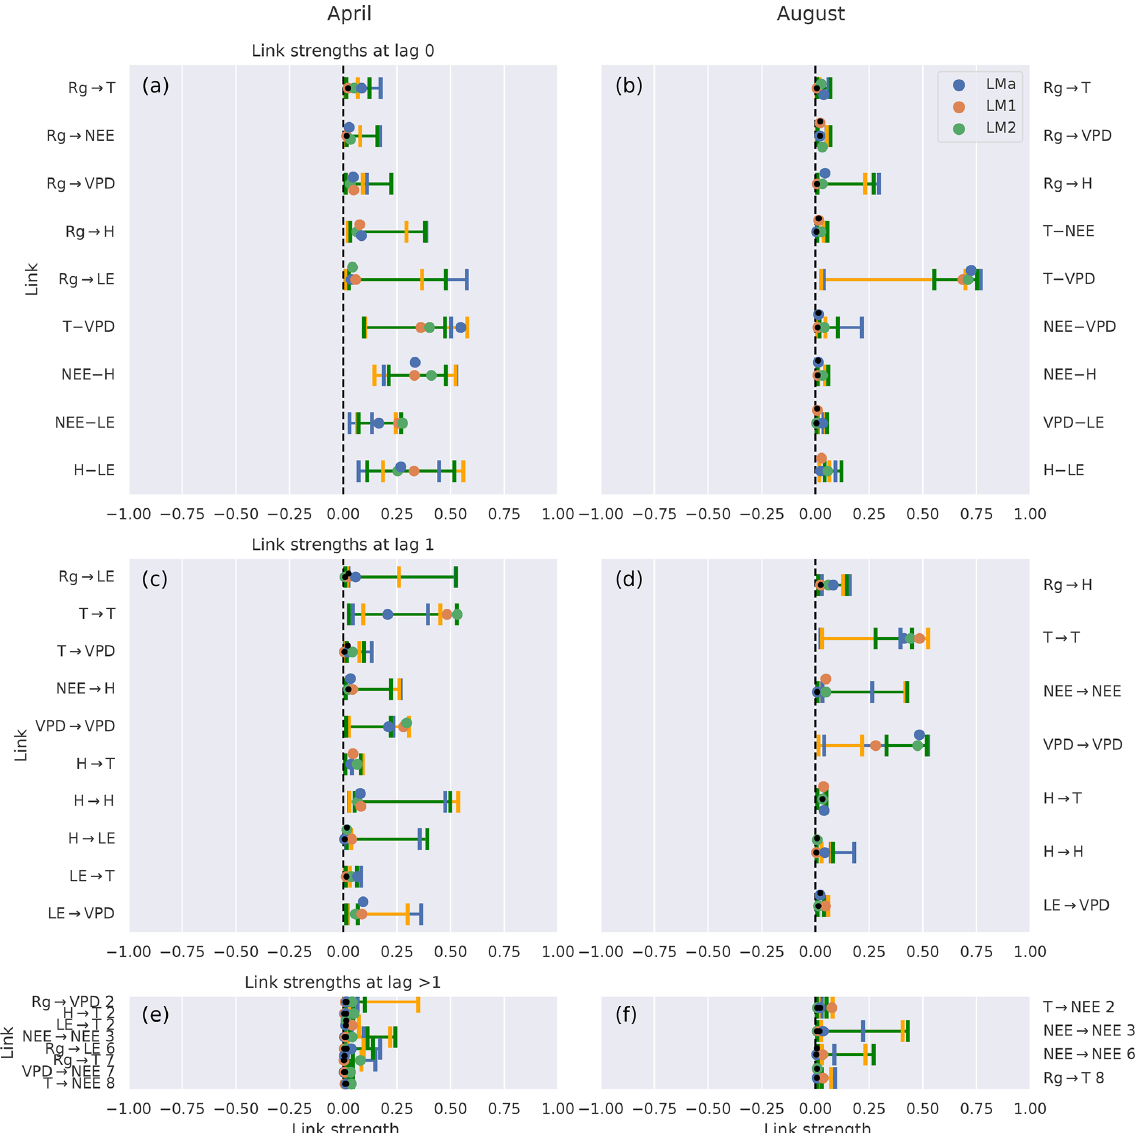
Figure A7. The same as Fig. 4, but the analysis was performed using a non-linear independence test. Comparison of the networks of three eddy covariance measurement stations (LMa, LM1, LM2) located in Majadas de Tiètar (Spain). Links that are found to be significant in one of the three networks are included. For each link, the calculated strength of all three networks is plotted with its 90% confidence interval. The colours blue, orange, and green correspond to the towers LMa, LM1, and LM2, respectively. The significance threshold is 0.01. If a link does not pass the significance, it is marked by a black dot. The links are grouped into lag 0 (a, b) , lag 1 (c, d) and all lags greater than 1 (e, f) . Links at lag 0 are left undirected ( − ), yet as R g is set as main driver, links incorporating R g at lag 0 are directed ( → ). Note that Gaussian process regression and distance correlation (GPDC) only yields positive link strengths. Further, the strength values estimated with GPDC are rather weak due to the low number of datapoints and the larger sensitivity of that method to the sample